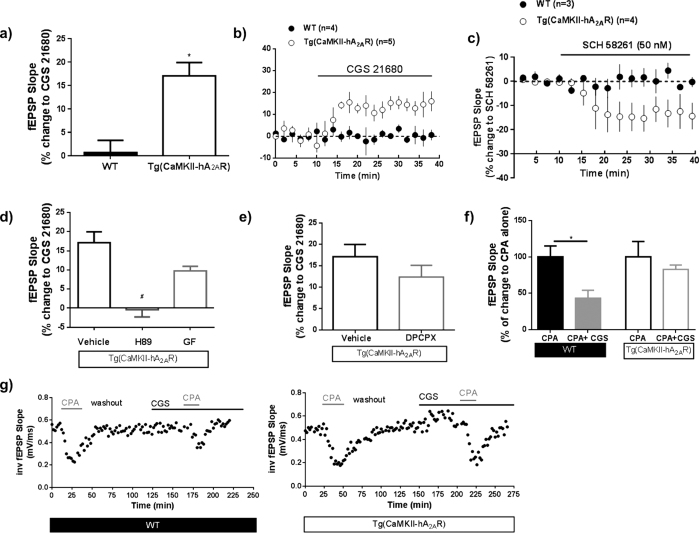
Overexpression of adenosine A2A receptor (A2AR) induces age-like modifications in adenosine neuromodulation.(a,b) The A2AR selective agonist CGS21680, 30 nM, has an effect on basal fEPSP slope in Tg(CaMKII-hA2AR) but not in WT animals ; Results were analyzed using a unpaired Student’s t-test (*P < 0.05 comparing to WT); (c) A2AR tonically increase excitatory transmission in Tg(CaMKII-hA2AR) animals, an effect revealed by the inhibitory effect of the A2AR selective antagonist SCH58261 (50 nM) on basal synaptic transmission, that was not observed in WT animals. (d) The effect of CGS21680, 30 nM is blocked by H89 (1 μM), a PKA antagonist, but not GF (1 μM) a PKC antagonist. Results were analyzed using One-way ANOVA followed by a Bonferroni’s multiple comparison post hoc test (#P < 0.05 comparing with Tg(CaMKII-hA2AR with CGS21680 alone). (e) The effect of A2AR activation does not change in the presence of the selective adenosine A1R antagonist DPCPX (100 nM;n = 3); P > 0.05 using a paired Student’s t-test analysis). (f) The effect of CGS58261 upon CPA, 30 nM, on fEPSP is lost in Tg(CaMKII-hA2AR) animals. Results were analyzed using a paired Student’s t-test comparing to CPA alone (n = 4/7, *P < 0.01 in WT animals comparing to CPA alone). (g) Time course of a representative experiment testing the A1/A2A crosstalk in WT versus Tg(CaMKII-hA2AR).